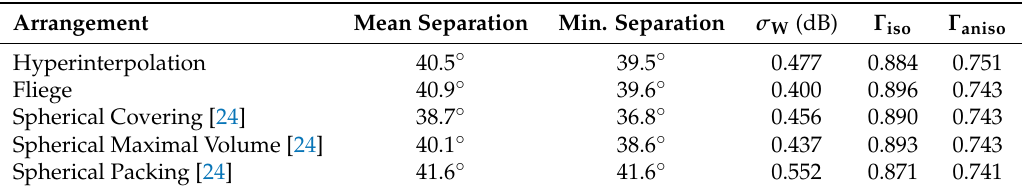
Table 1. Evaluation of 5 different arrangements of 25 look directions over the sphere. The mean and minimum separations refer to the angular distance between nearest-neighbor look directions. σ W is the standard deviation in the total combined directivity W ( Ω ) (Equation (13)), and Γ is calculated using Equation (15).